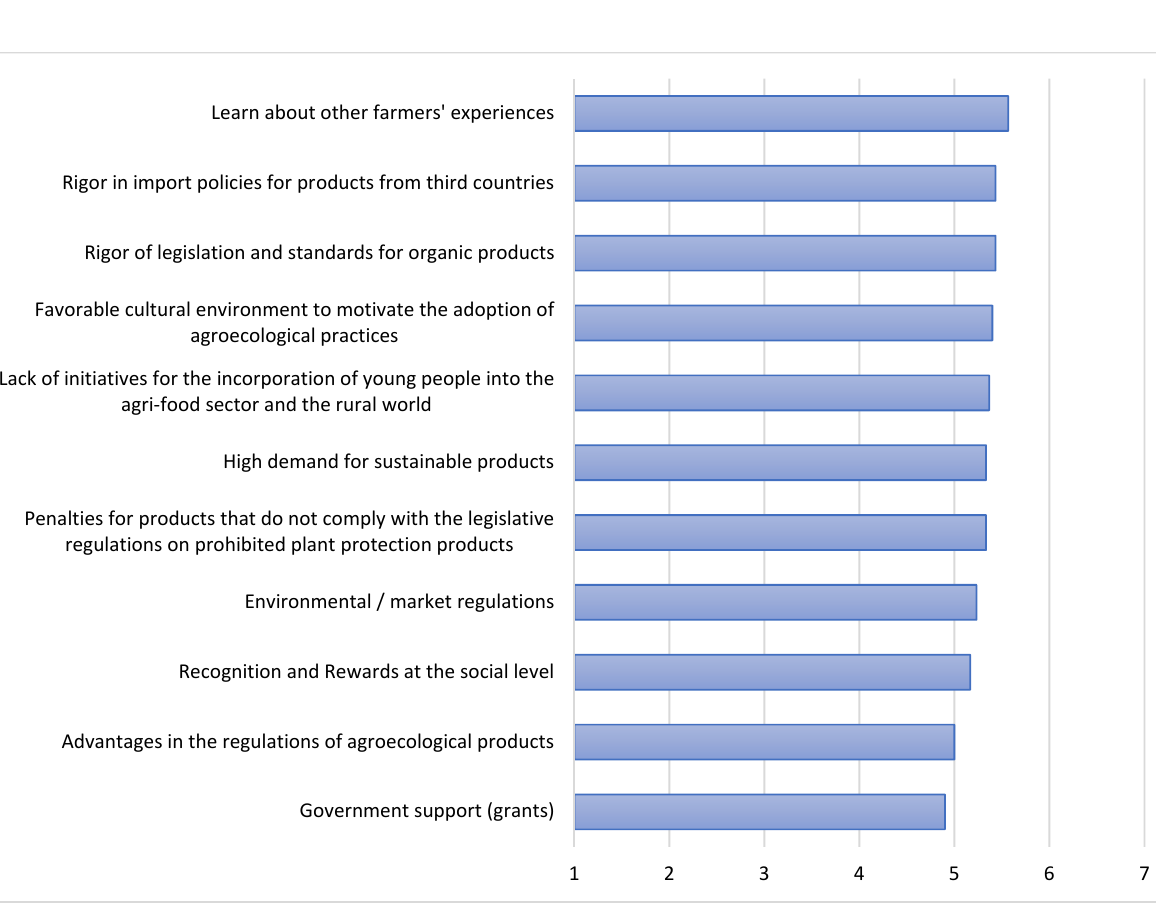
Figure 6. Scalar average according to the degree of importance of a series of factors on adoption of agroecological practices. The benefits most perceived by farmers are “Agroecology reinforces the health and well-being of the soil, environment, producer and consumer”, “Agroecology allows to protect and/or conserve ecosystems”, “Agroecology reduces environmental deterioration” and “Agroecology incorporates ancestral values and knowledge of an avant-garde character”. The aspects that received the lowest valuation were “Agroecology increases sovereignty of the farmer”, “Agroecology allows the generation of medium-high benefits”, “Agroecology eliminates hunger, poverty